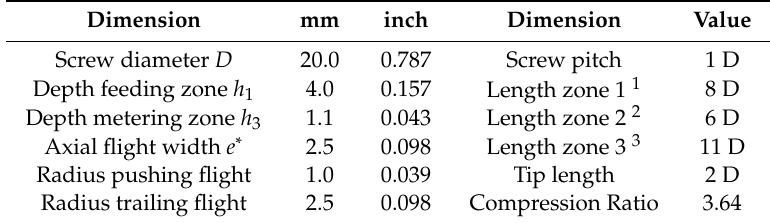
Table 1. Dimensions of the three-section screw.